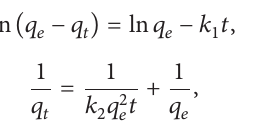
Figure 3: Adsorption kinetics of MBP onto D-201 and D-301 at 298 K. (a) Fitting by Pseudo-first-order equation. (b) Fitting by Pseudo-second-order